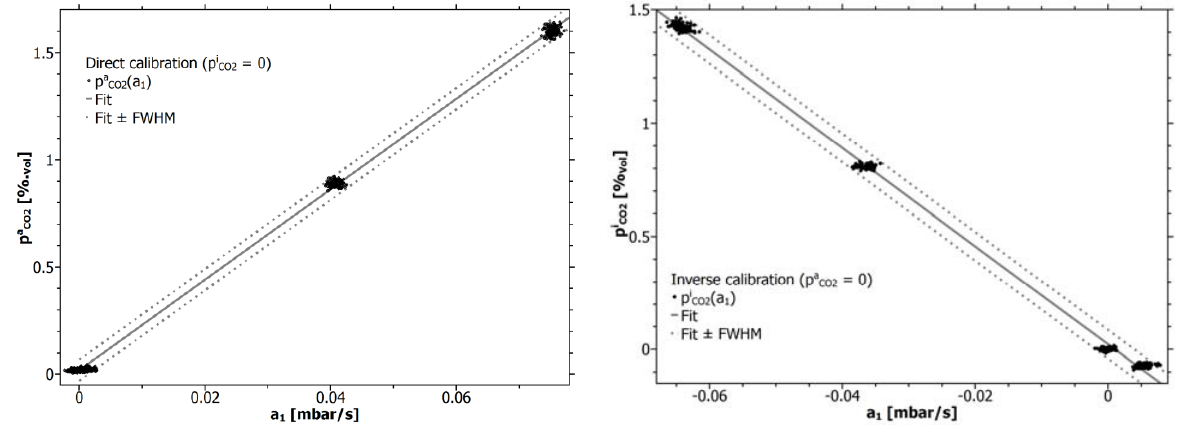
Figure 4. Results from direct ( left ) and inverse calibration ( right ). Mirror inverted slopes of the response functions result from the different orientations of the diffusive fluxes through the membrane wall. Dashed lines limit the 2.35-fold of the standard deviation (FWHM is full widths at half